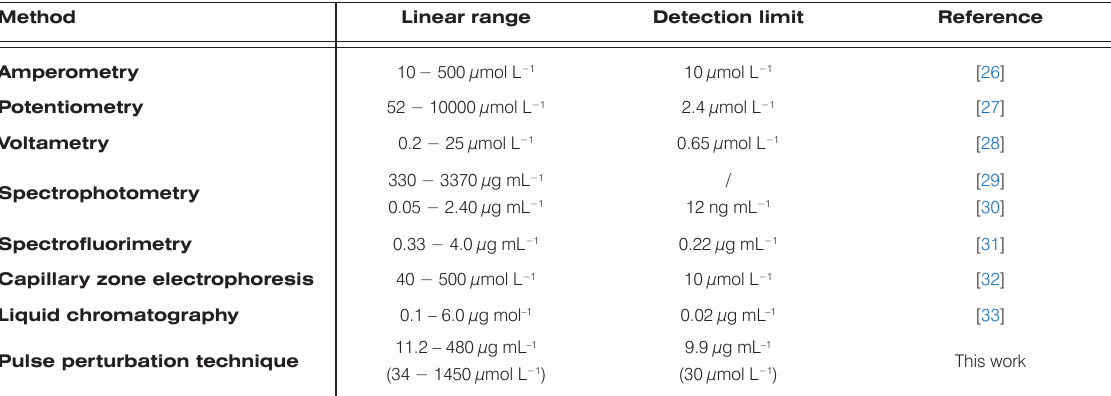
a Correlation coefficient; b Limit of detection established at a signal−to−noise ratio of 3; c Limit of quantification established at a signal−to−noise ratio of 10; d Average relative standard deviations obtained from three determinations of 23.2 µg mL –1 , 99.4 µg mL –1 and 298.2 µg mL –1 ; e Sample throughput is the number of sample measurements per hour. Table 2. Comparison of analytical performances of the previously reported method with the proposed method.